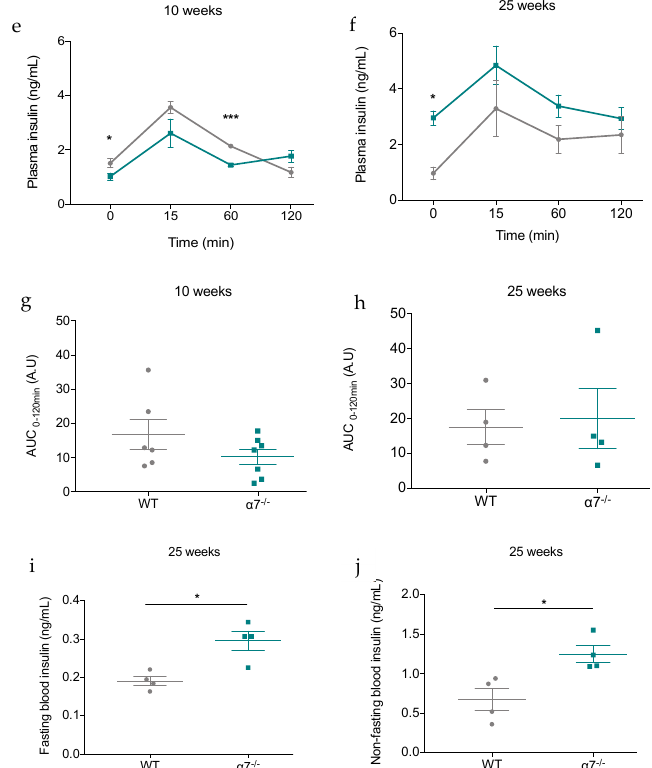
Figure 2. Glucose metabolism is impaired in α 7 − / − mice fed a standard chow diet. All experiments in this figure were carried out in 10- and 25-week-old male WT control and α 7 − / − mice. Glucose tolerance test was performed in overnight fasted mice with intraperitoneal injection of glucose (IPGTT) at 1.5 g / kg of body weight ( a , b ). Blood samples were taken at the time indicated from the tail vein of the same animals, and the area under the corresponding curve of blood glucose levels was calculated during 120min ( c , d ). Glucose-stimulated insulin secretion during IPGTT was analyzed at 0, 15, 60 and 120 min ( e , f ), and the area under the corresponding curve plasma insulin levels was calculated during 120min ( g , h ). Blood insulin levels under fed ( i ) and fasted ( j ) conditions in 25-week-old α 7 − / − and WT control mice. Each dot represents a mouse (grey dots for WT mice and green squares for α 7 − / − mice). All data are presented as mean ± SEM. Symbols *, **, *** and **** indicate a significant di ff erence compared to control WT using Two-Way RM ANOVA ( a , b , e , f ; n = 6–7 / group, * p < 0.05; ** p < 0.001; *** p < 0.0005; **** p < 0.0001) and unpaired Mann–whitney two-tailed test ( c , d , g – j ; n = 4–7 / group, * p < 0.05). AUC, area under